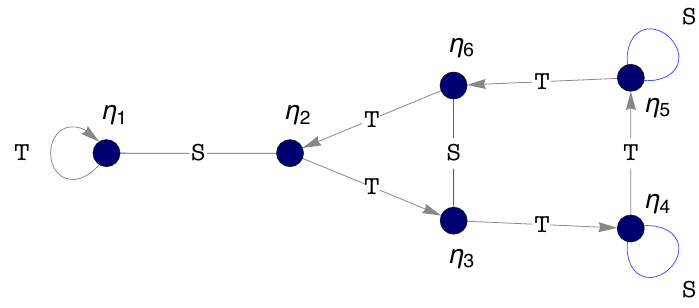
Figure 3 . Graph illustrating the automorphisms of the set of seed functions (cid:17) i ( (cid:28) ), de(cid:12)ned in eq. (D.5), under the actions of (cid:0) 5 ’ A 5 generators S and T